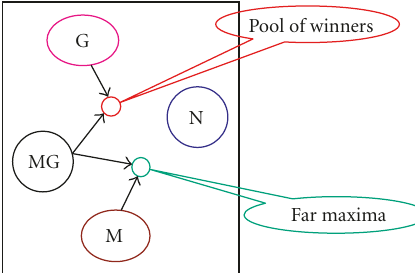
Figure 8: The four di ff erent classes of corners. “G”: good corners that have only voted for the pool of winners, and they are present inside the “Corners set”. “MG”: mixed-good corners that have voted for both the pool of winners and the far maxima set, and they are present inside the “Corners set”. “M”: malicious corners that have only voted for the far maxima, and they are present inside the “Corners set”. “N”: neutral corners that have not voted for the pool of winners or the far